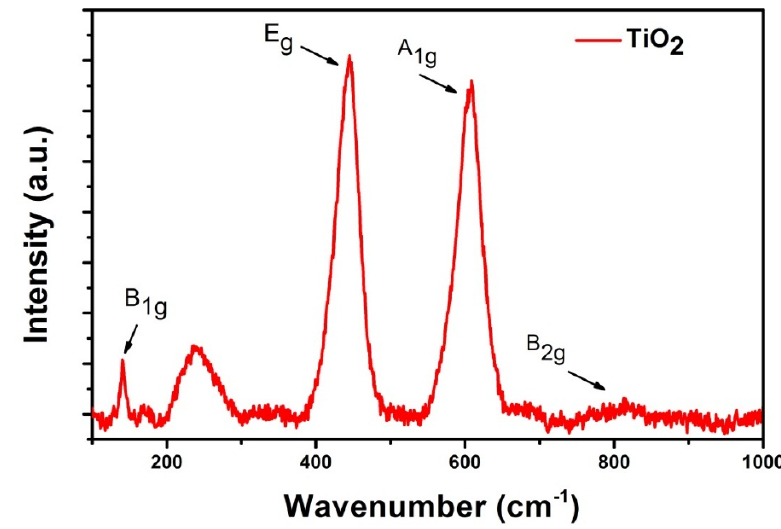
Figure 6. Raman spectrum of TiO 2 nanowires growth at 700 °C, 10 SCCM oxygen, and 100 SCCM argon flow for 3 h.